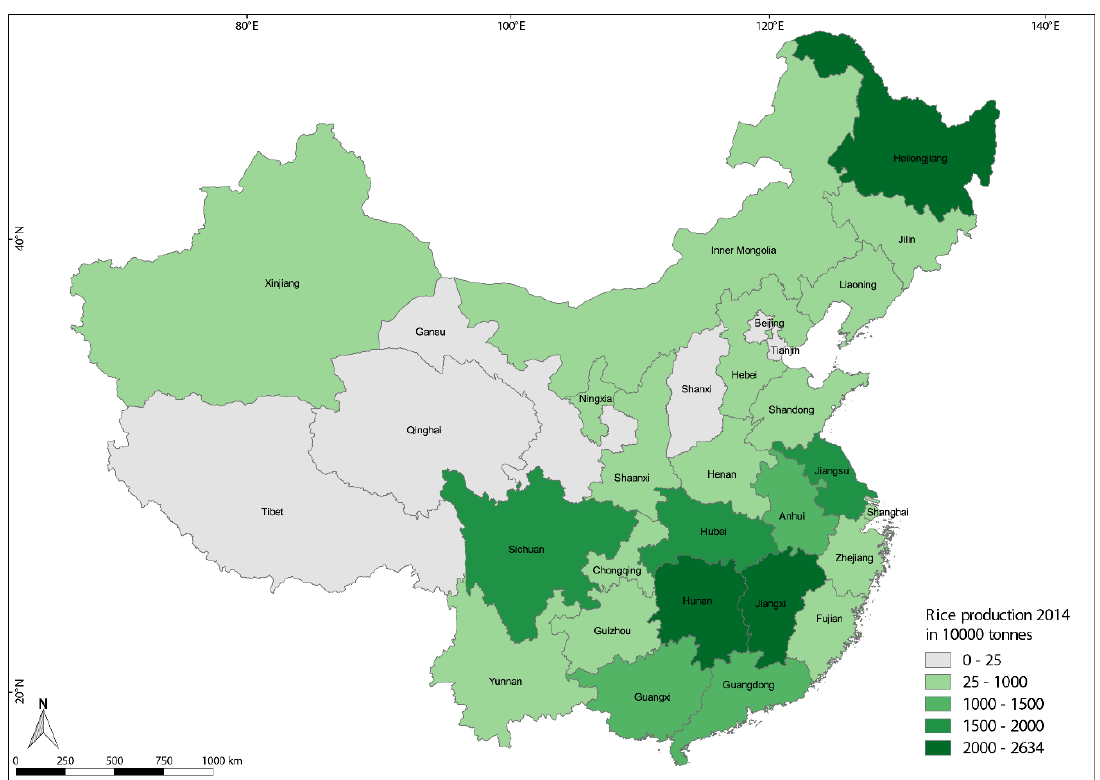
Figure 1. Rice production in mainland China 2014. Based on data from [2].